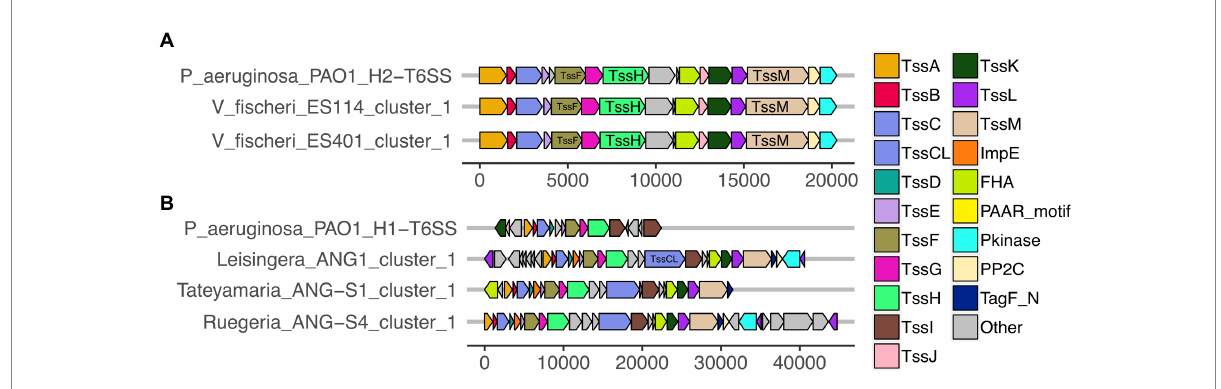
FIGURE 2 Predicted T6SS gene clusters of Euprymna scolopes symbiont genomes share similar gene organization to T6SS gene clusters in Pseudomonas aeruginosa PAO1. Each of the T6SS core structural and accessory genes are colored, non-T6SS genes are labeled as “other” and are gray. Genes are drawn to scale at the bottom of each cluster, measured in bp. (A) The T6SS1 of Vibrio fischeri genomes share similar gene content and organization to the H2-T6SS of P. aeruginosa PAO1. (B) The first T6SS clusters of ANG strains share similarity to the H1-T6SS of P. aeruginosa